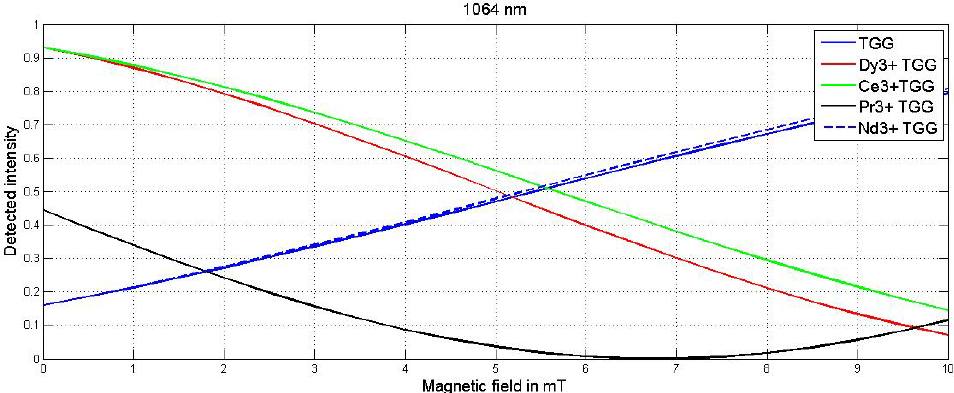
Figure 4. Variation of detected intensity ( I out ) with magnetic field ( B ) wavelength of TGG, Dy 3 + doped TGG, Ce 3 + doped TGG, Pr 3 + doped TGG and Nd 3 + doped TGG at 1064nm for analyzer angles 42, 50, 50, 50 and 42 ◦ , respectively (Table 4).